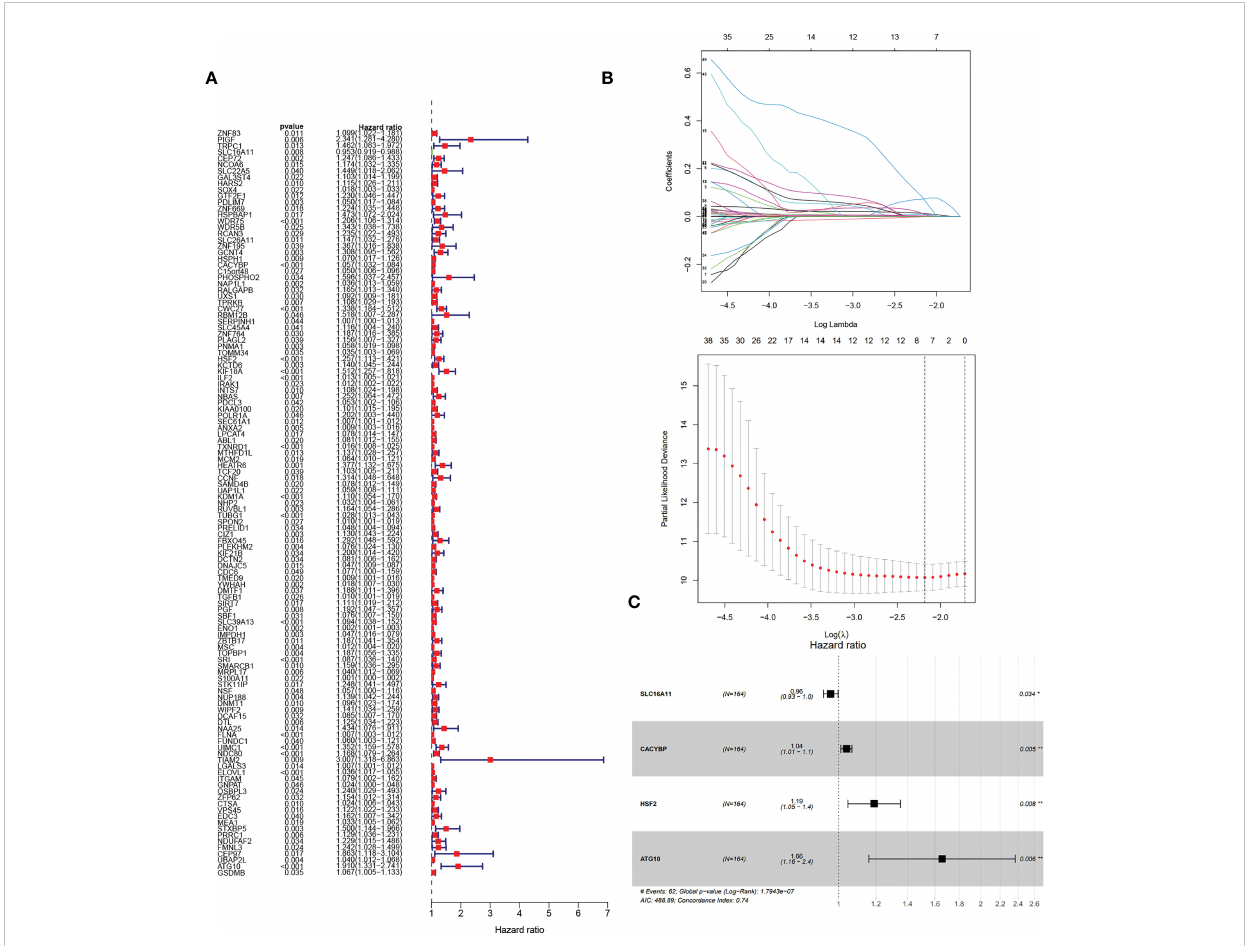
FIGURE 5 Construction of Tex-related HCC prognostic model. (A) The prognostic Tex-related genes extracted by univariate Cox regression analysis. (B) LASSO regression analysis and coef fi cients of Tex-related HCC prognostic model-constructed genes obtained by LASSO. (C) Multivariate analyses of model genes obtained from lasso regression analysis in the TCGA cohort. Hazard ratios are adjusted by the variables shown in this fi